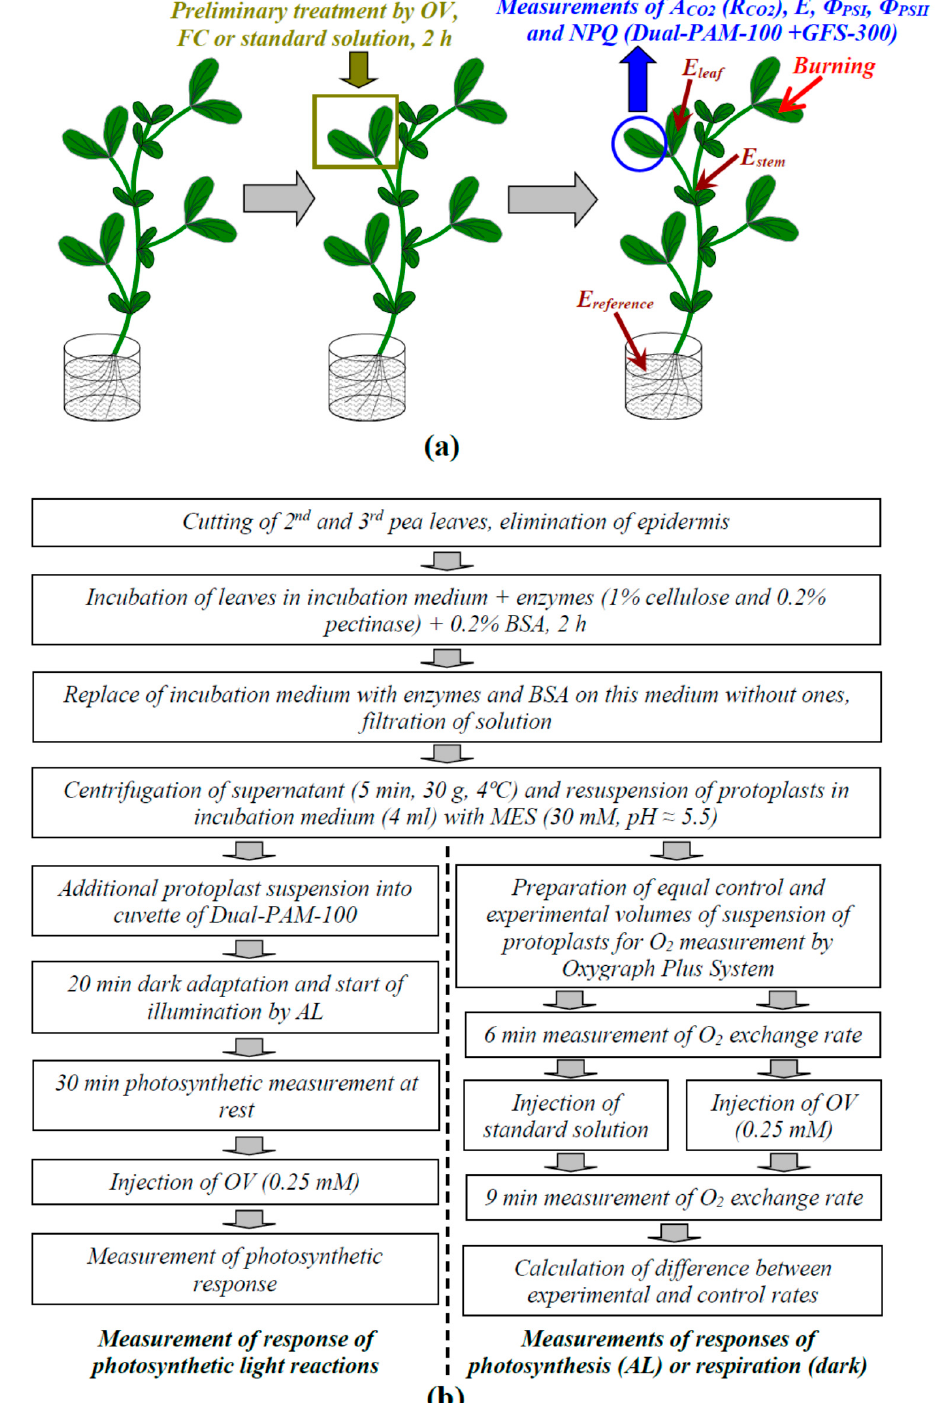
Figure 11. ( a ) Schema of investigations of the influence of the preliminary modification of the activity of H + -ATPase in the plasma membrane on electrical signal-induced photosynthetic and respiratory responses. Activity of H + -ATPase was decreased by leaf treatment with sodium orthovanadate (OV) and increased by treatment with fusicoccin (FC). The preliminary OV (0.5 mM) and FC (1 µM) treatments of the second mature leaves in seedlings was performed by incubation of the leaf (2 h) in solutions of these chemical agents. After that, these leaves were dried using filter paper and used for extracellular measurement of photosynthetic and electrical activities. OV and FC were dissolved in standard solution (1 mM KCl, 0.5 mM CaCl 2 , and 0.1 mM NaCl). Similar treatment using the standard solution was used as the control. The arrows mark the local burning of the first mature leaf (flame, 2–